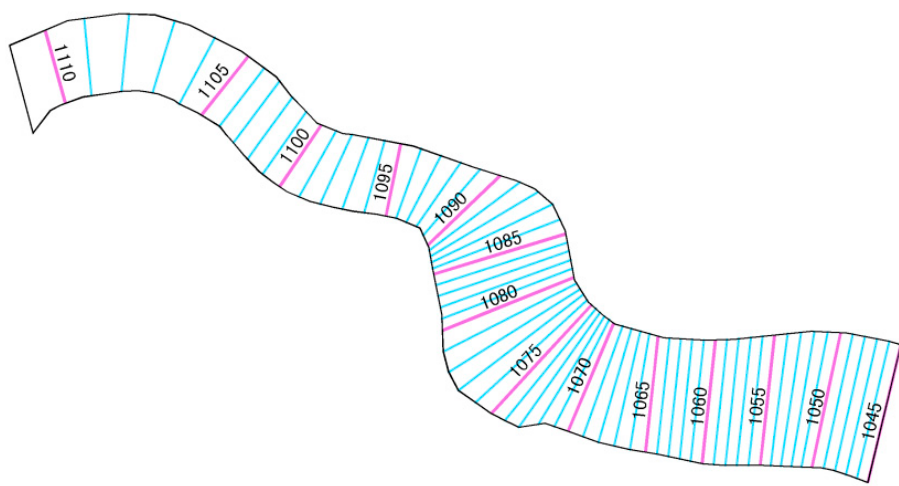
Figure 5. The contour lines that are perpendicular to the centerline and as even as possible.